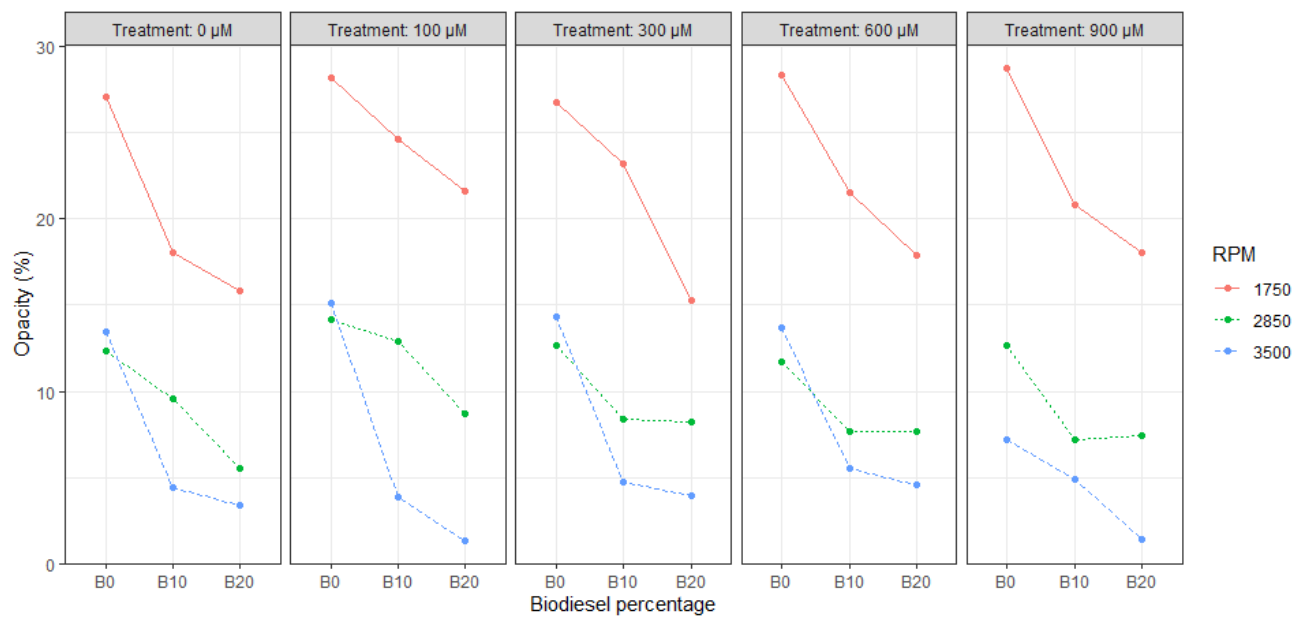
Figure 4. Correlation plot between opacity, SA content, RPM, and biodiesel percentage.